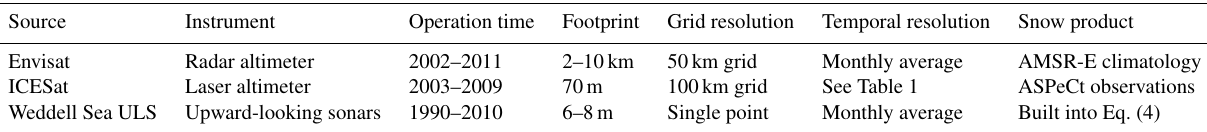
Table 2. A summary of the sea ice thickness data used during the comparison, including different data sources, spatial resolutions, temporal resolutions and snow